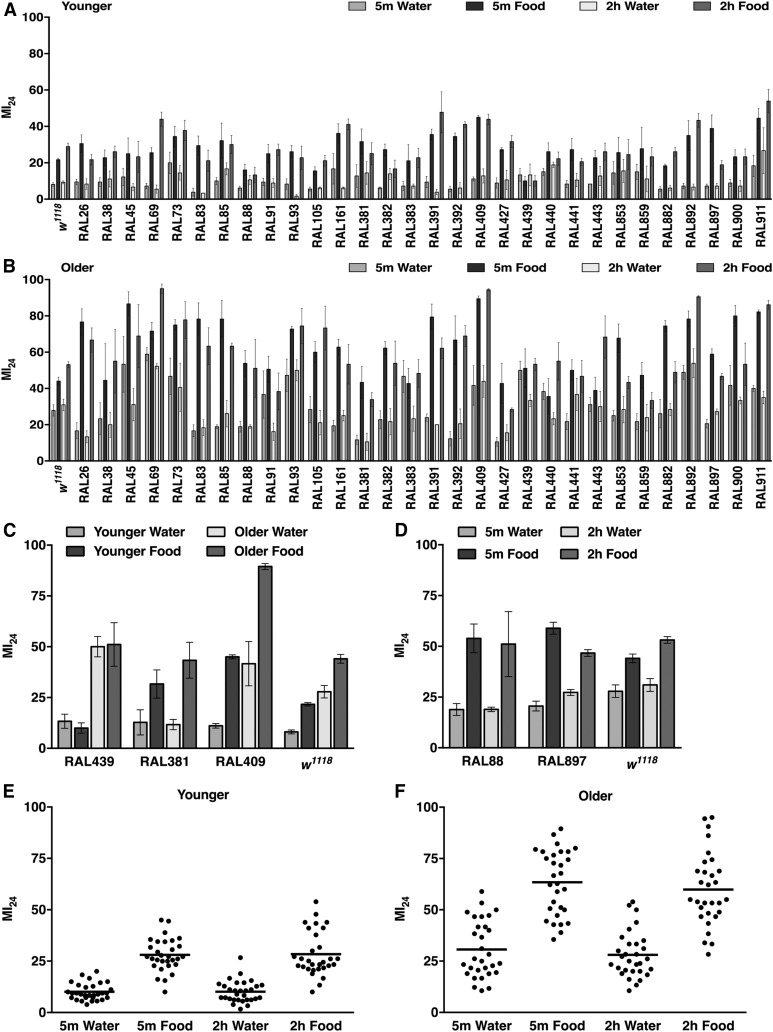
Age, diet, and interinjury interval have different effects on the MI24 in different genetic backgrounds. Shown is the MI24 of 30 RAL lines subjected to TBI with 5 min or 2 hr interinjury intervals at (A) younger or (B) older ages and subsequently fed water or food. Each data point is the average and SEM of at least three biological replicates. (C) Representative fly lines from (A and B) whose MI24 was affected by age but not diet (RAL439), diet but not age (RAL381), or both age and diet (RAL409 and w1118) following the standard injury protocol. (D) Representative fly lines from (B) whose MI24 was not affected by interinjury interval (RAL88), reduced at 2 hr vs. 5 min under the food condition (RAL897), or increased at 2 hr vs. 5 min under the food condition (w1118). The average MI24 for the set of 30 RAL lines treated at (E) younger or (F) older ages. Each dot represents a single RAL line and the horizontal line indicates the average among fly lines. The average MI24 was significantly different (P < 0.0001, one-tailed t-test) between younger water and younger food as well as between younger water and older water for both 5 min and 2 hr intervals. In contrast, the average MI24 was not significantly different (P > 0.05, one-tailed t-test) between 5 min and 2 hr intervals for both younger and older flies fed either water or food.